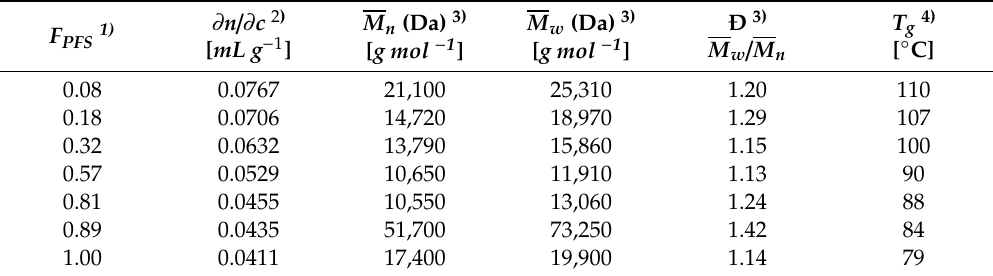
Table 3. Molecular Weight Distribution Data & Glass Transition for PFS / MMA